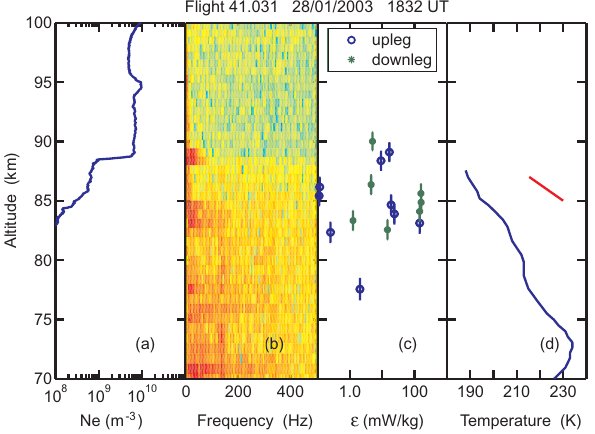
Fig. 8. Same as Fig. 2 except data obtained 28 January 2003, 18:32 UT (Flight 41.031), from Esrange, Sweden.